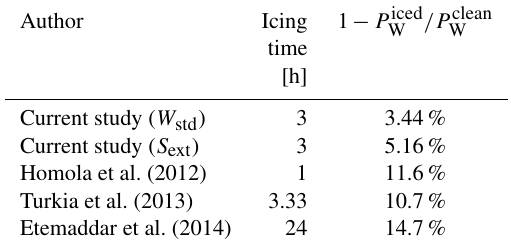
Table 7. Weibull-averaged power loss computed for the current study and compared with other